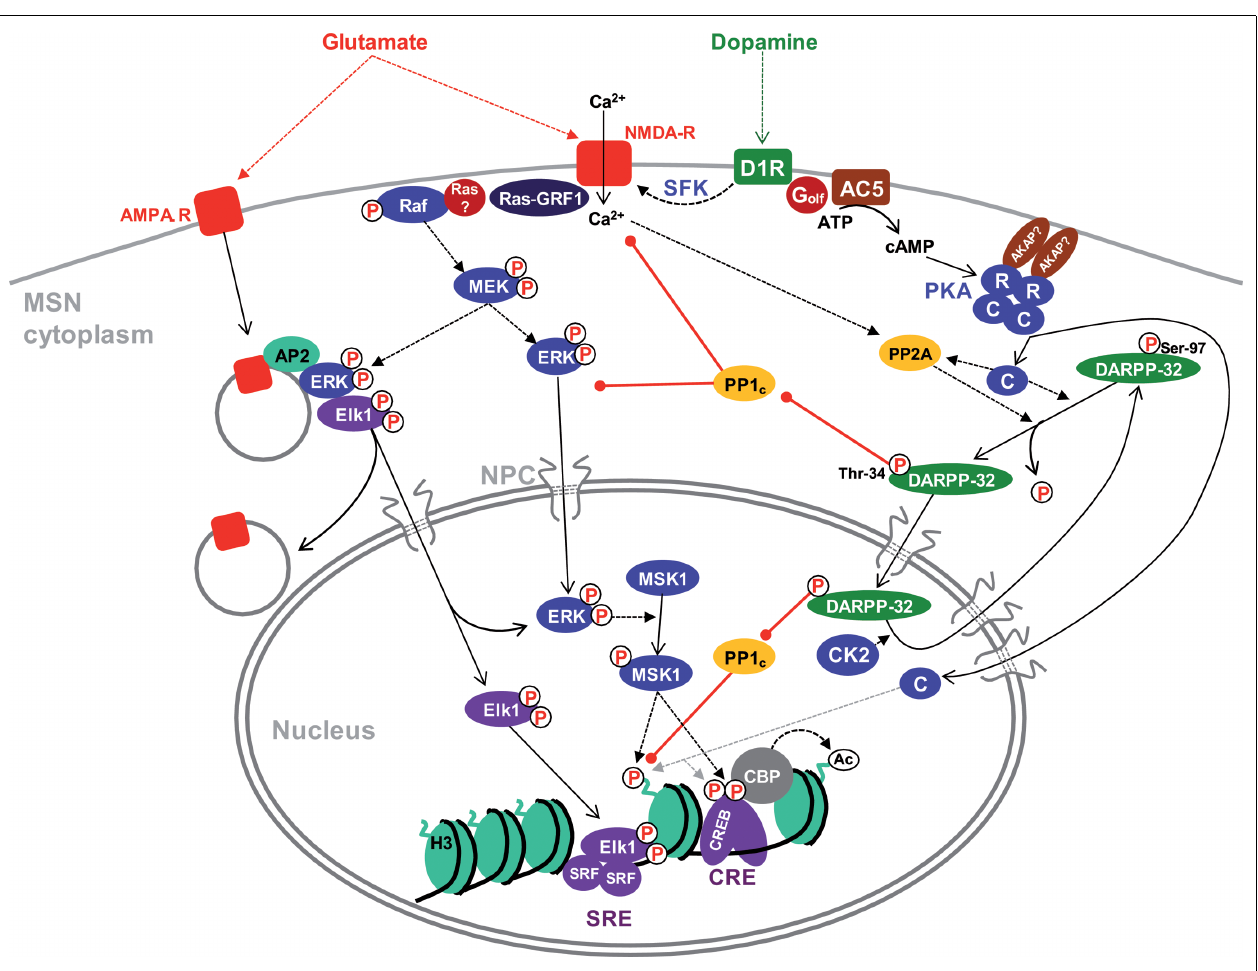
cyclase (mostly AC5 isoform) through the stimulatory heterotrimeric G olf protein containing the α olf and γ 7 subunits.The inactive PKA heterotetramer is usually anchored through AKAPs, yet to be characterized in MSNs. cAMP binds to the regulatory subunits (R) and releases the catalytic subunits (C). C subunits phosphorylate numerous substrates in the cytoplasm and diffuse to the nucleus where they can phosphorylate proteins such as CREB or histone H3. In MSNs however, a nuclear resident protein kinase, ERK-activated MSK1, plays a major role in CREB and H3 phosphorylation. CREB recruits CBP which has histone acetyltransferase activity. PKA phosphorylates DARPP-32 onThr-34, turning it into a potent inhibitor of PP1 catalytic subunit (PP1c). DARPP-32 continuously cycles between the cytoplasm and the nucleus and its nuclear export is facilitated by phosphorylation of Ser-97 by CK2, which is present in the cytoplasm and nucleus of MSNs. PKA increases nuclear DARPP-32 by inducing the dephosphorylation of Ser-97 by PP2A. Dotted arrows indicate influences or catalysis, solid arrows displacement. Red arrows with a round end indicate inhibition. NPC, nuclear pore complex. See text for